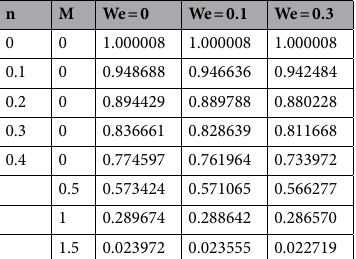
C f √ Re x when S = 0.5, R = 0.2, Pr = 2, Nb = 0.1, Nt = Table 2. Variation of −